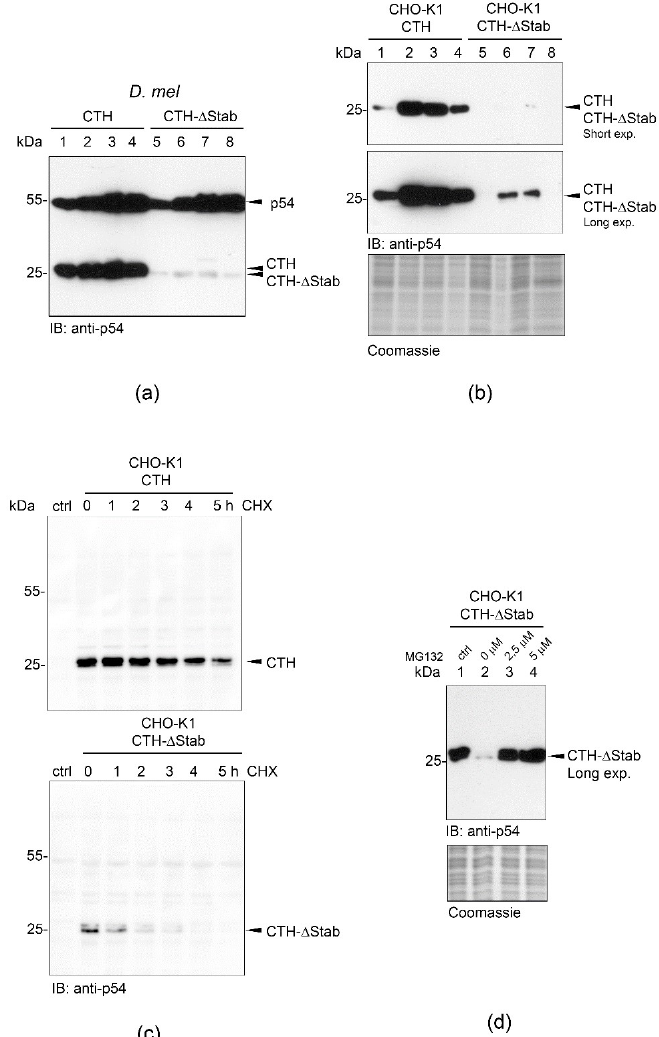
Figure 1. High-level accumulation and intracellular stability of CTH are STABILON-dependent. ( a ) CTH (lanes 1–4) or CTH-∆Stab (lanes 5–8) transgene expression was analyzed in total protein ex- tracts prepared from 2nd (lane 1 and 5) or 3rd instar larvae (lanes 2 and 6), pupae (lane 3 and 7) or adults (lane 4 and 8), respectively, by immunoblotting using CTH-specific monoclonal antibody